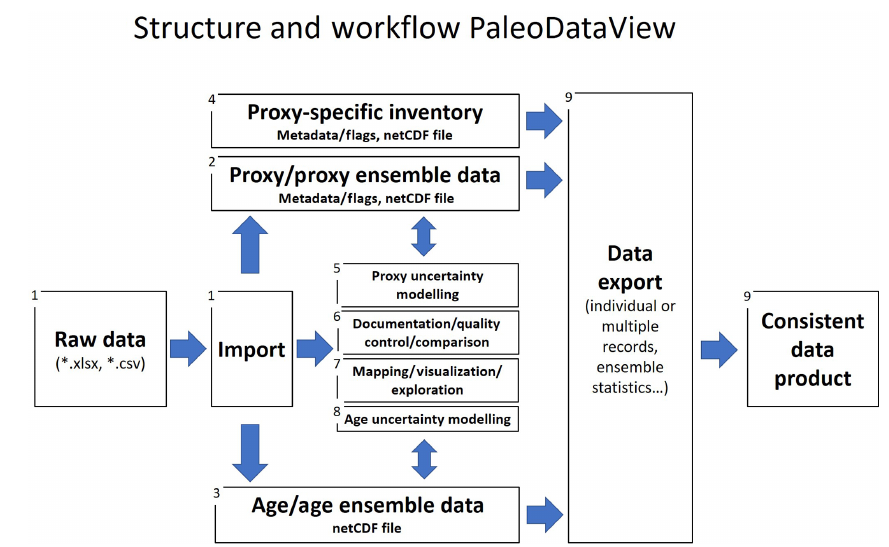
Figure 1. Workflow of the PDV-Toolbox. Data can be imported (1) from Excel or text files and are separated into a netCDF file containing metadata and downcore proxy data (2) and a netCDF file containing all age-related data (3). An inventory file is created (4) and constantly updated containing only the metadata of all records in the database. This file allows fast access to individual files in the database. Functionality within the toolbox includes proxy uncertainty modelling (5), commenting, flagging and documentation of data/metadata (6) and tools for visualization (7) and age modelling (8). Individual time series or proxy ensemble time-series statistics for individual or a collection of records can be exported in various file formats